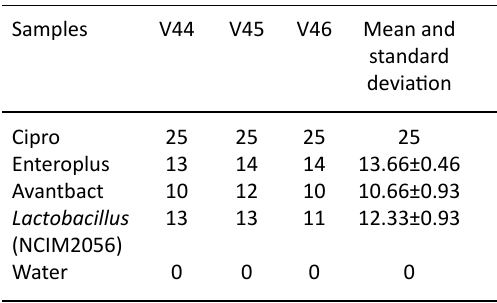
Table 1. Zone of inhibition (mm)